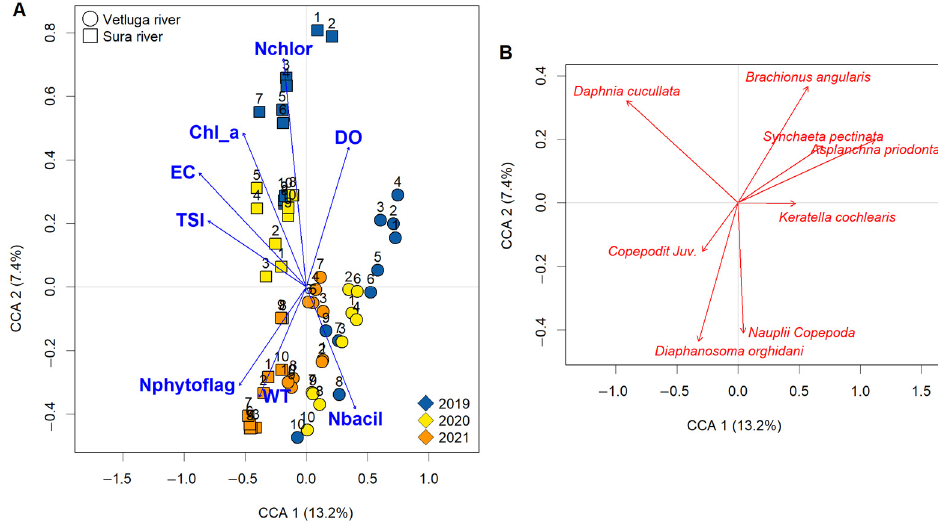
Figure 4. Zooplankton communities’ CCA ordination plots (( A )—samples and factors; ( B )—dominant zooplankton species). The decoding of the factors is presented in Table 4.